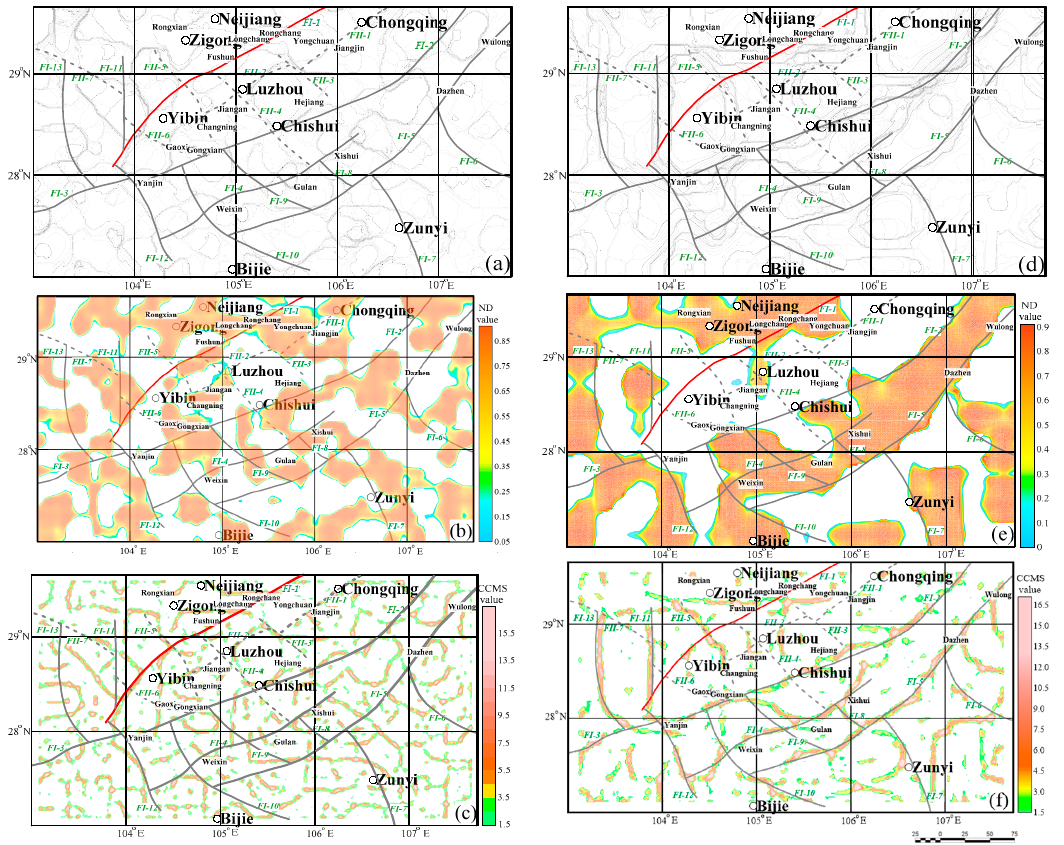
Figure 8. The result map of different edge-detected methods ( a ) SSDF, ( b ) ND and ( c ) CCMS reflect the shallow information; ( d ) SSDF, ( e ) ND and ( f ) CCMS reflect the deep information.